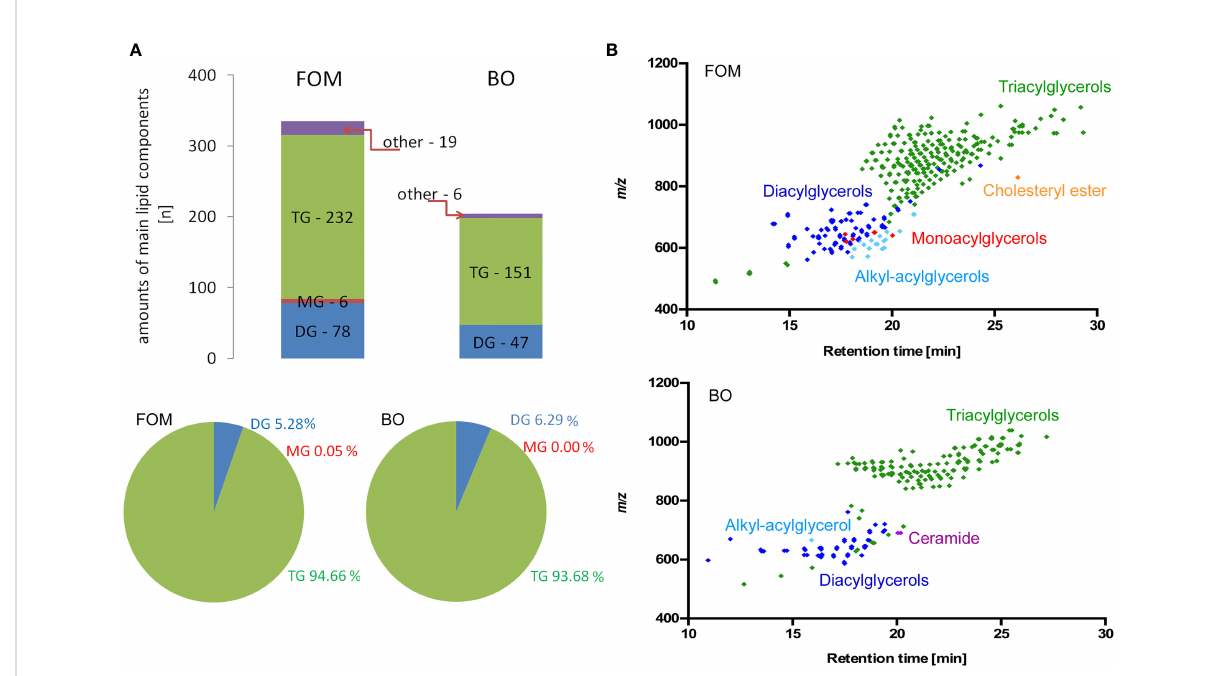
FIGURE 7 The comparative analysis of lipid species in FOM vs . BO by RP-LC-Q-Orbitrap HRMS technique displayed signi fi cantly more compounds in FOM compared to BO, despite similar percentages of all TG, DG, and MG in both oils. (A) The number and percentage of the lipid species divided into main lipid categories: MG, monoacylglycerol; DG, diacylglycerol; TG, triacylglycerol. (B) Retention time (RT) vs . mass-to-charge ratio ( m/z ) plots for lipid species identi fi ed in FOM and BO using RP-LC-Q-Orbitrap